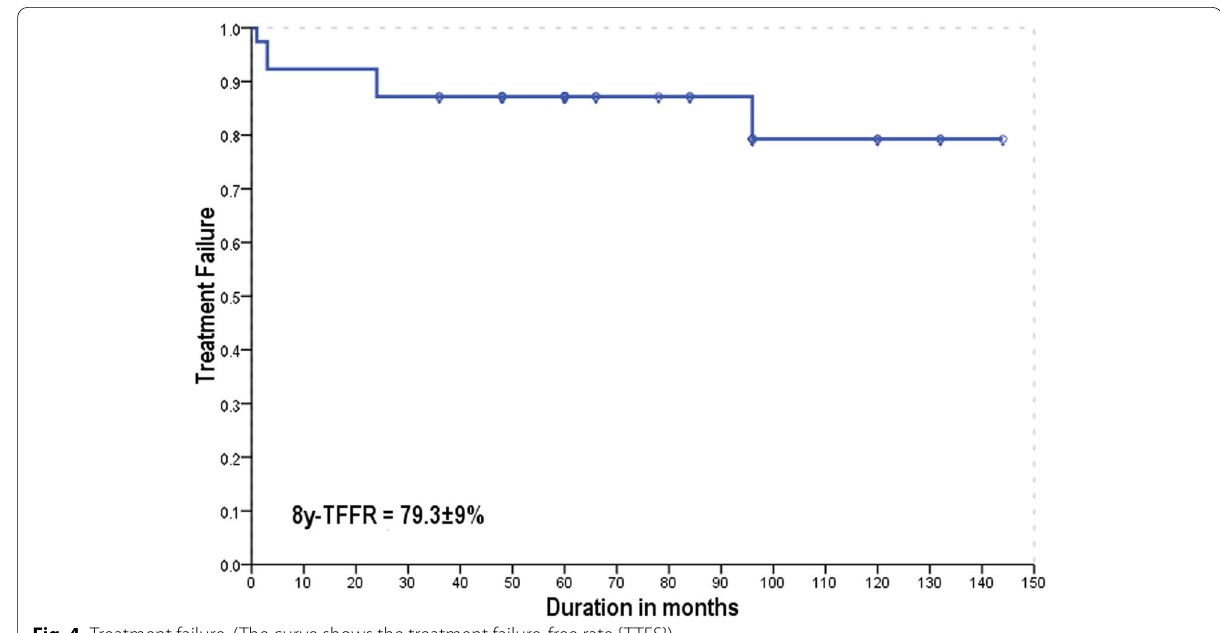
Fig. 4 Treatment failure. (The curve shows the treatment failure-free rate {TTFS})